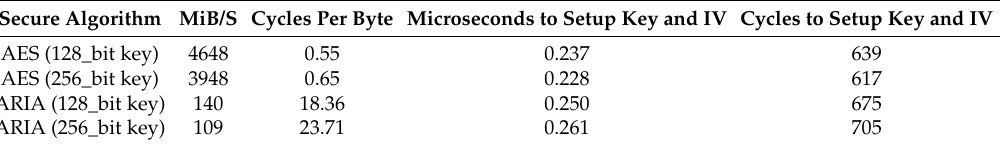
Table 7. Secure algorithm benchmark on proposed system using Crypto++.